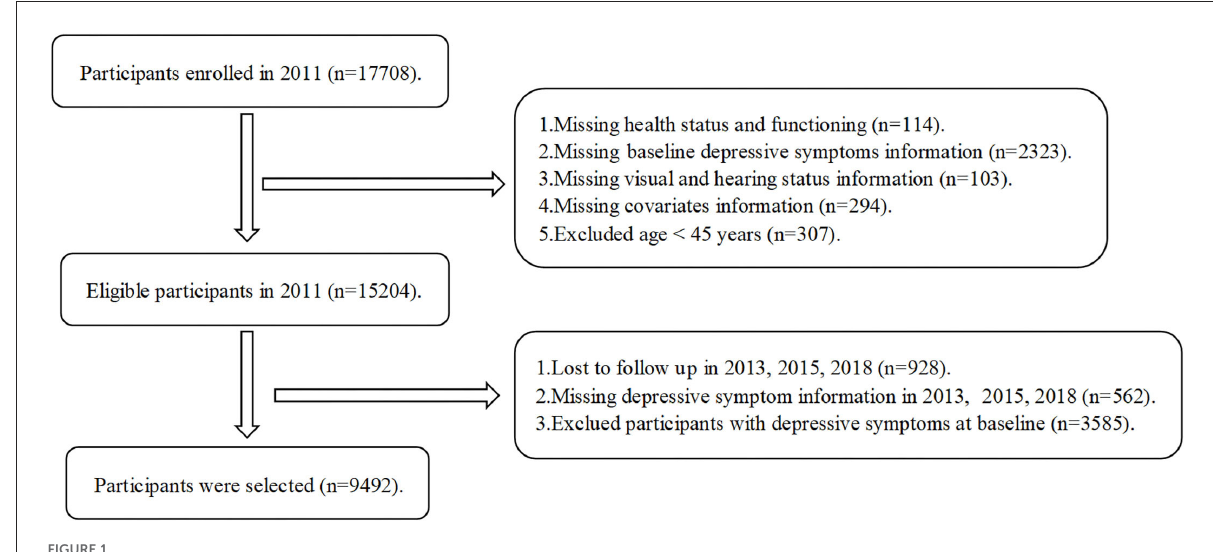
FIGURE1 Flowchart of the selected participants from the